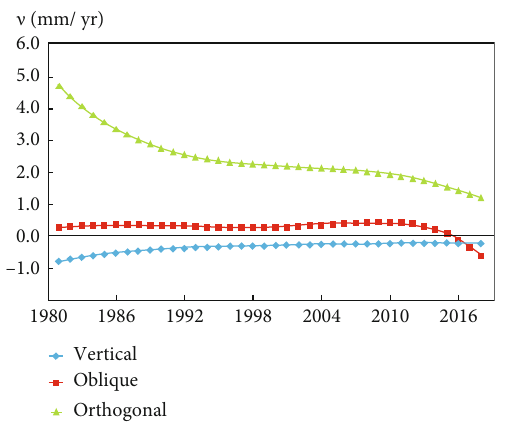
Figure 9: Measured long-term creep rates of three directions from the cross-fault measurements that have been conducted by SEISEA since